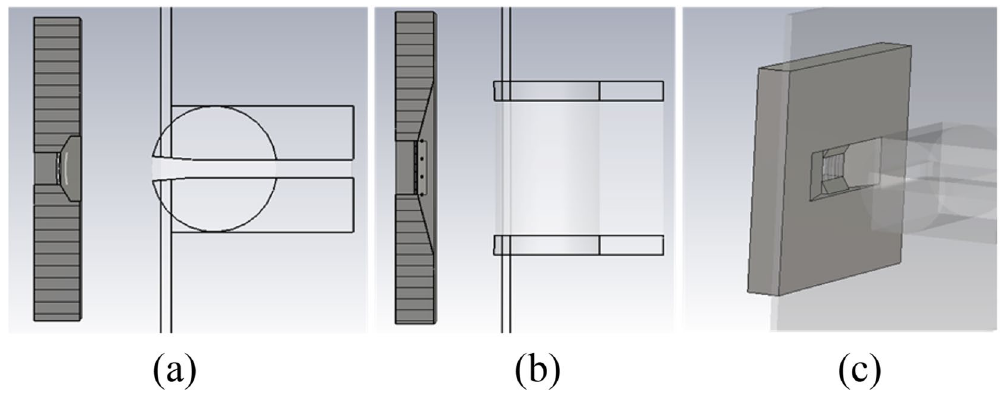
Figure 9. Configuration of the focusing electrode in the three-beam electron gun. ( a ) In the y–O-z plane. ( b ) In the x-O-z plane. ( c ) 3D